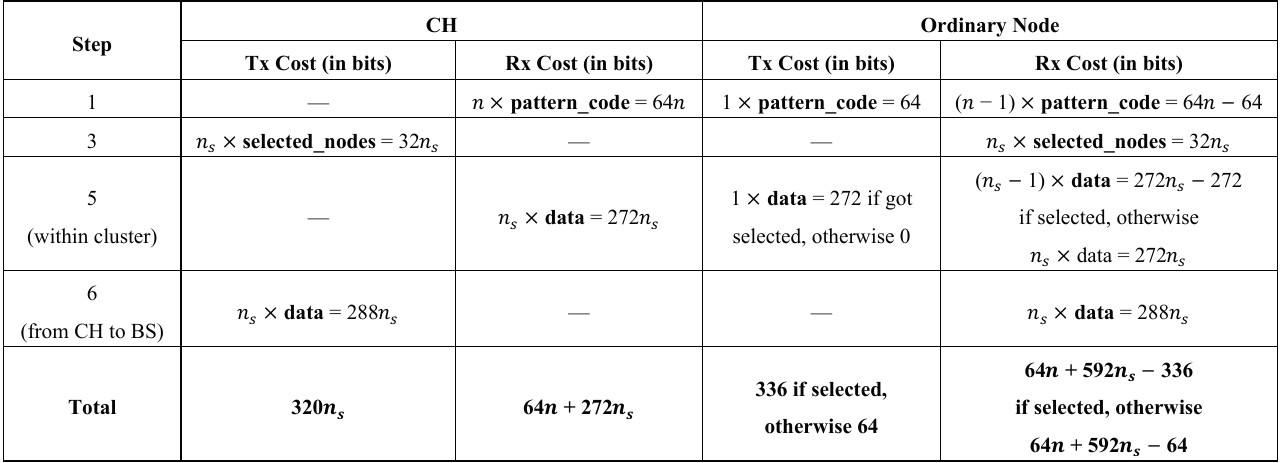
Table 13. Communication cost of ESPDA in data aggregation phase.